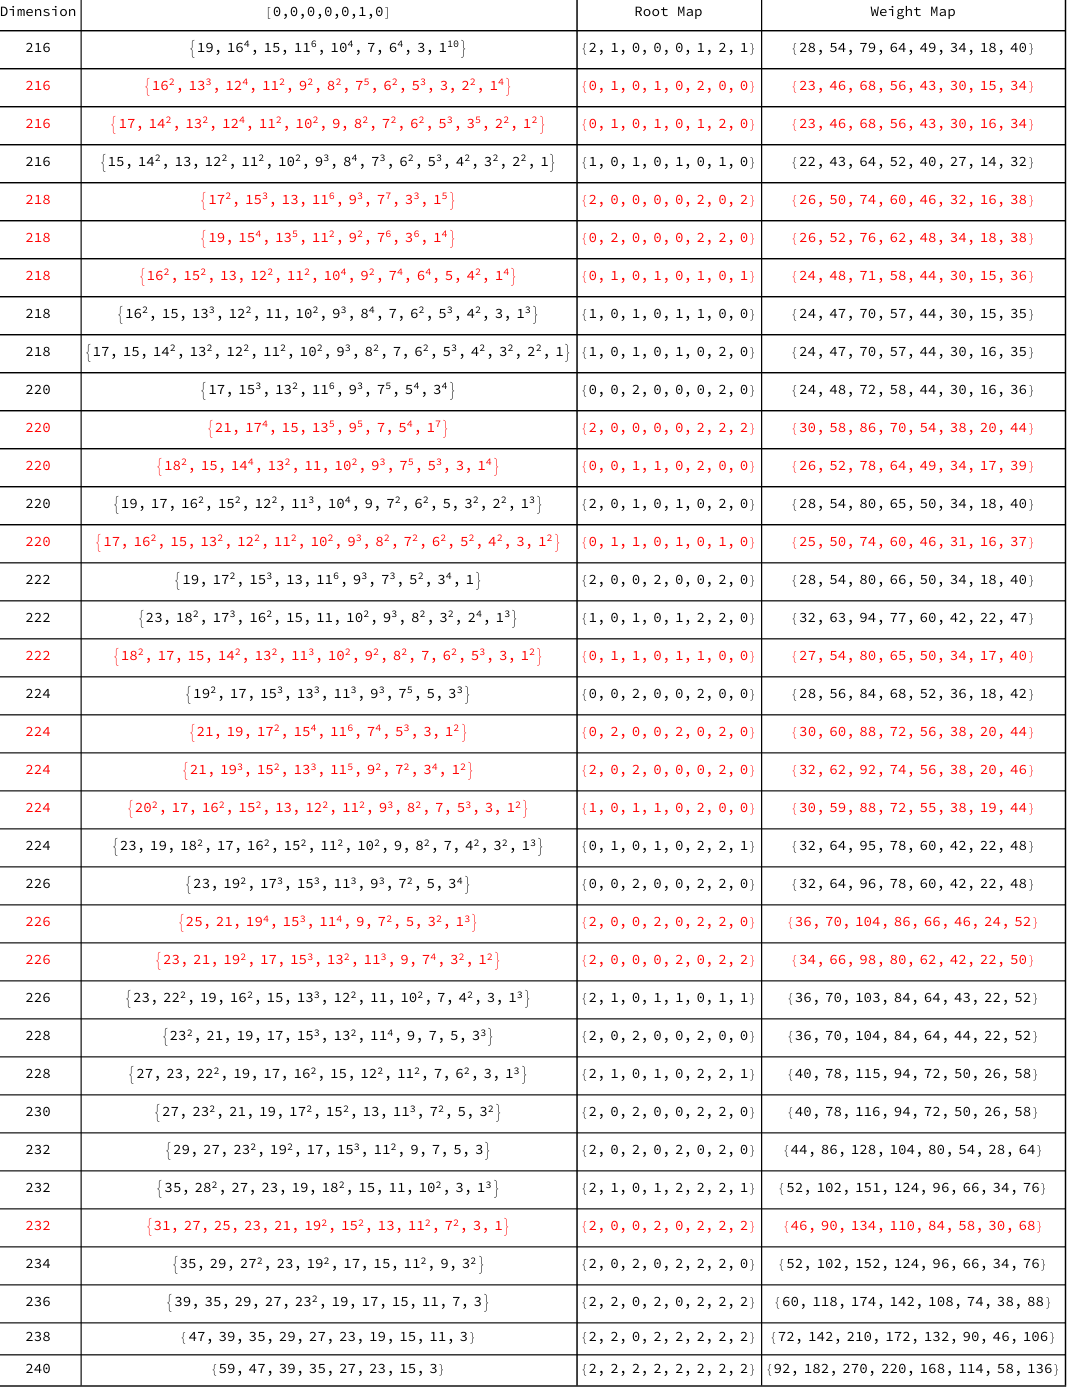
Partitions are shown for the adjoint representation only. Homomorphisms identi(cid:12)ed in- clude 39 root maps which are not recognised Characteristics of nilpotent orbits: these are highlighted in